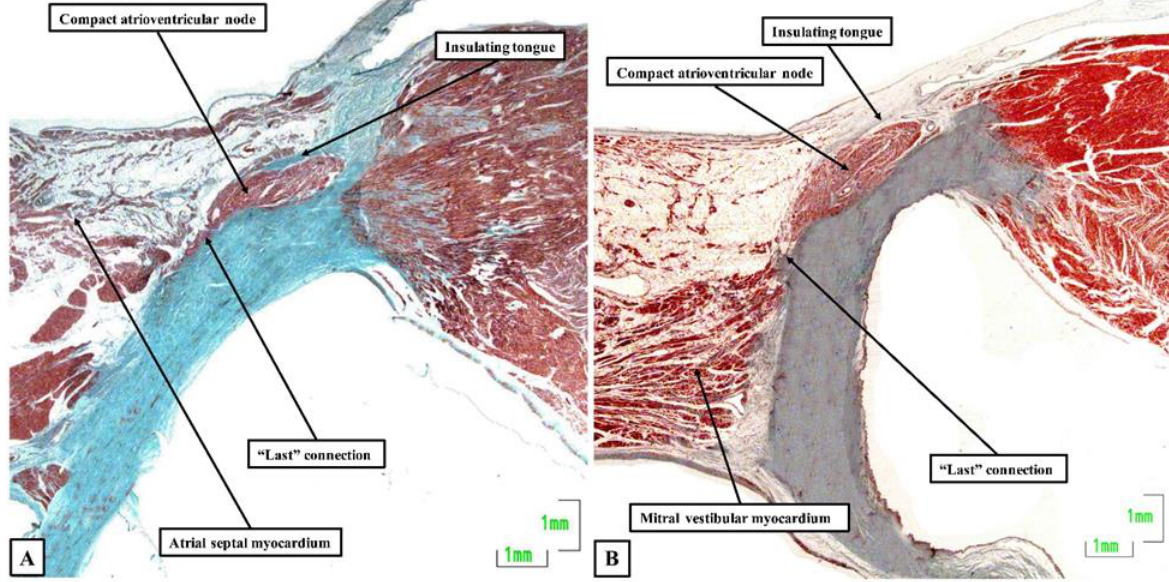
Figure 2 . The compact node and the last connection: The sections, again stained using the trichrome technique, show the last connections to the atrioventricular node from the central part of the atrial septum ( A ) as opposed to the mitral vestibule ( B ). The section shown in Panel A is from the same series of sections as shown for the atrioventricular node and penetrating bundle in Figure 1. Both sections are taken from adult human hearts .